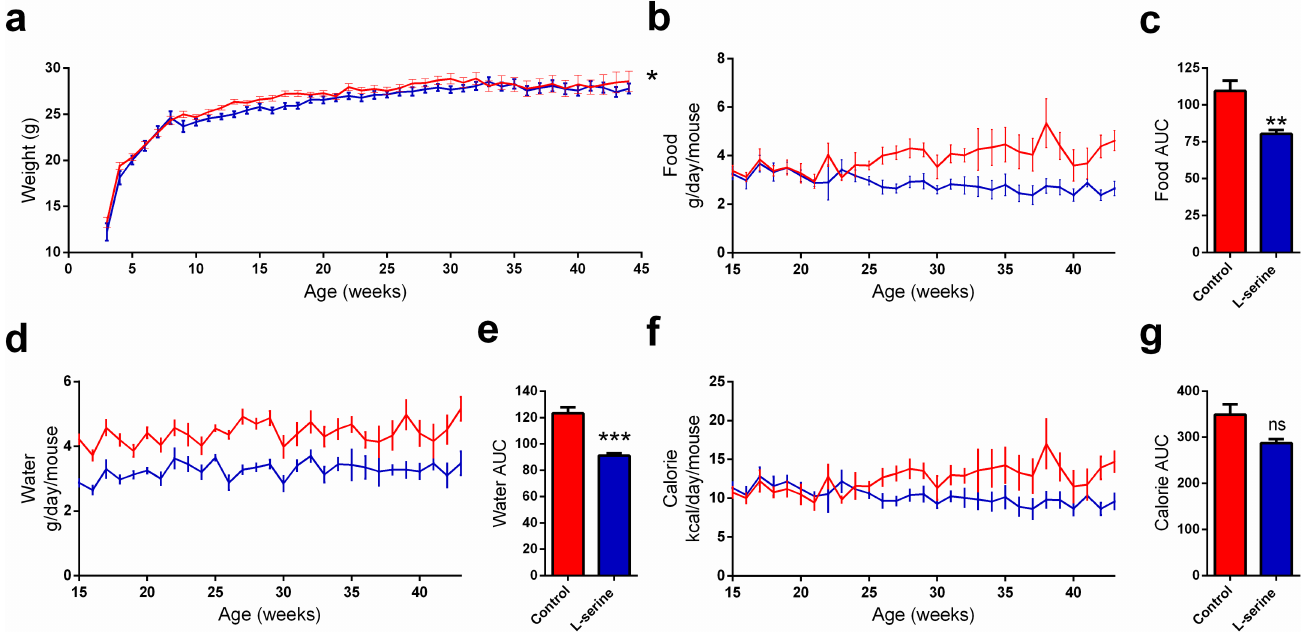
Fig 3. L-serine supplementation reduces body weight. (a) Body weight as measured once a week in healthy NOD mice, control (n = 49), and L-serine (n = 30). p = 0.045 (b) Food intake was calculated per cage by weighing the food racks, control (n = 5) and L-serine (n = 4). (c) Area under the curve (AUC) calculation for food intake, p = 0.01. d) Water intake as calculated per cage by weighting of water flasks, control (n = 5) and L-serine (n = 4). AUC calculation for water intake, p = 0.001. (f) Calorie intake was calculated to adjust for the intake of L-serine through water, control (n = 5) and L-serine (n = 4). AUC calculation for calorie intake, p = 0.054. Control is shown in red and L-serine in blue. Statistical tests: mixed model (a) and unpaired two-tailed Student’s t-test (c, e g). Data is shown as mean ± SEM. (cid:3) p < 0.05; (cid:3)(cid:3) p < 0.01; (cid:3)(cid:3)(cid:3) p < 0.001.